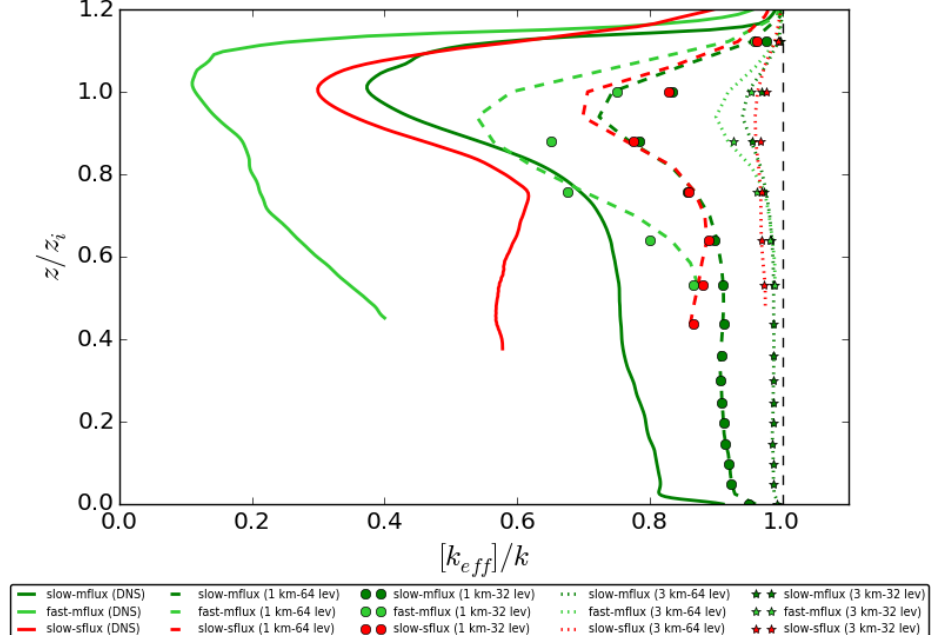
Figure 9. Vertical profiles of the horizontally averaged normalised effective chemical reaction rate [ k eff ] /k from the four coarse-grid models with homogeneous emissions for the slow-mflux (in dark green), fast-mflux (in light green) and slow-sflux (in red) cases time averaged for the last 30min of the simulations. Note that the vertical profiles are not plotted at altitudes where the concentration of tracer B is equal to